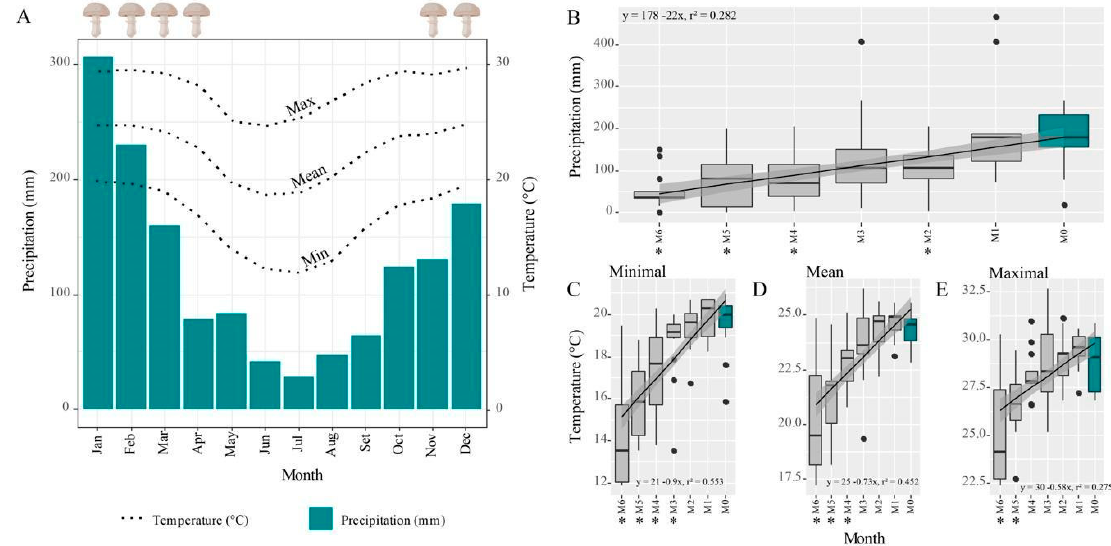
Figure 3. Basidiomes were more frequent during warm and wet seasons. ( A ) Annual climate panorama (1994–2021) of Rio Claro (State of São Paulo, Brazil) with basidiome occurrences from November to April. ( B – E ) Six-month interval of climatic data between occurrences (in blue) and months preceding them. Overall, no differences were found between the two months preceding the occurrences (see details of analysis in Table S4), which followed the periods with increased temperature and precipitation. Asterisks indicate statistical differences for the Mann–Whitney U test between the previous months and the month of basidiome